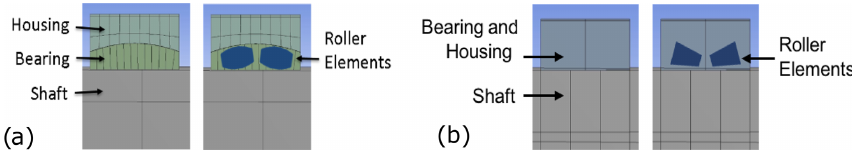
Figure 3. (a) A split view of the SRB FE model displaying the geometries of the bearing and housing. (b) A split view of the TRB FE model displaying the geometries of the bearing and housing. Note: the roller elements and mesh displayed in these images are for illustrative purposes only; a finer mesh was used for the simulations.